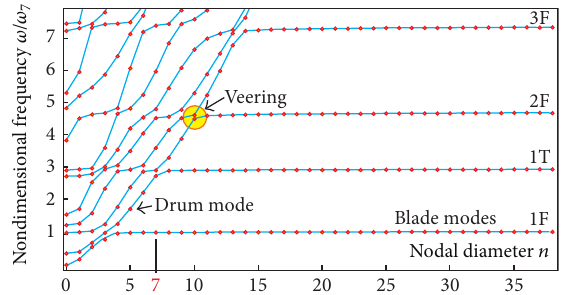
Figure 1: Bladed drum considered in this study.